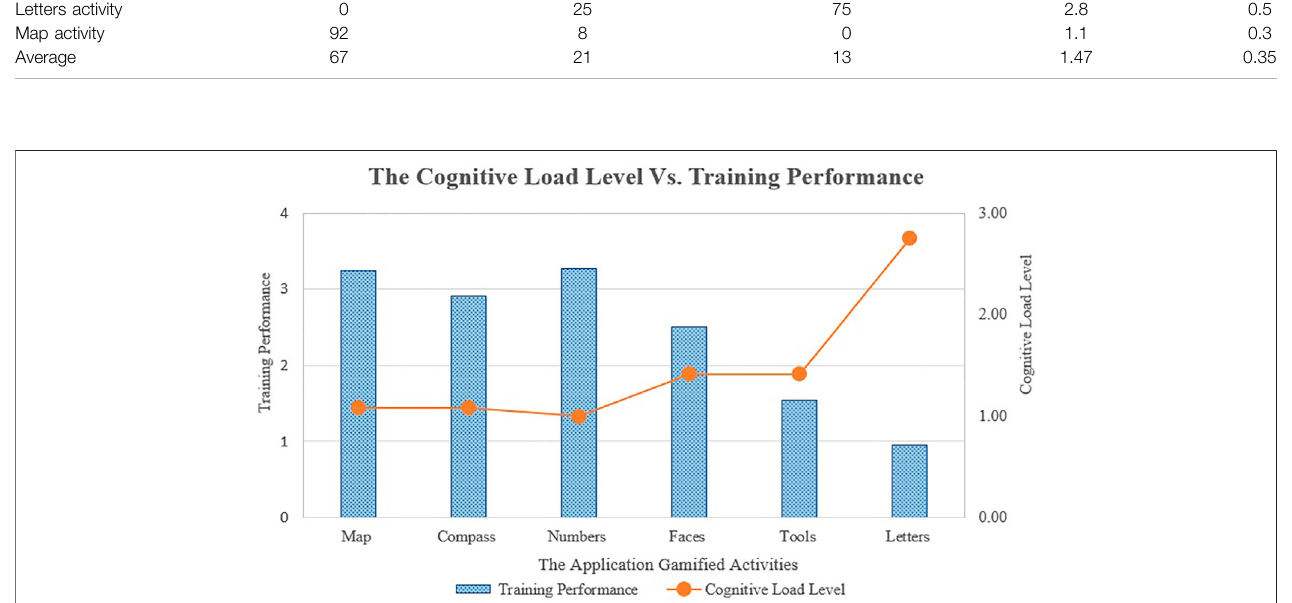
FIGURE 8 | Cognitive load level vs. the children ’ s training performance. It compares between the average of cognitive load level imposed by each activity for the entire experimental sample group and the children ’ s training performance (the average of the stars achieved by all children over all training sessions in each activity).